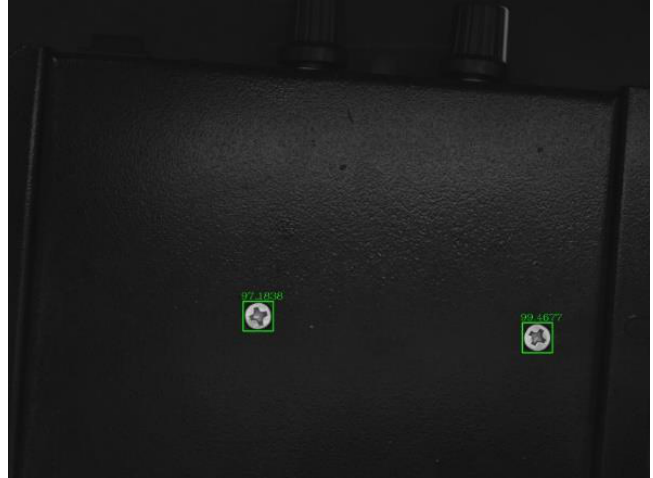
Figure 13. Detection results.